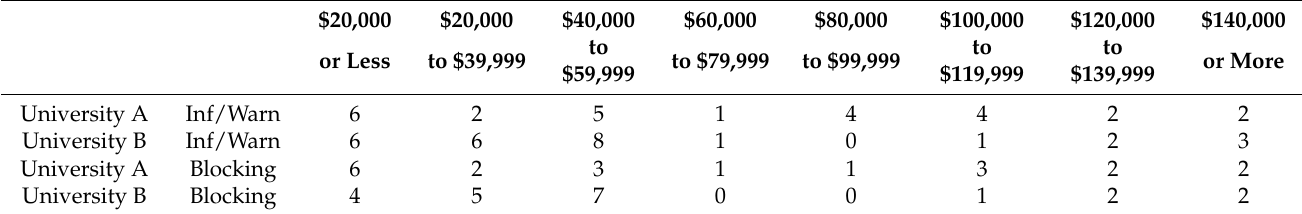
Table 27. Income ranges of participants in information/warning and blocking